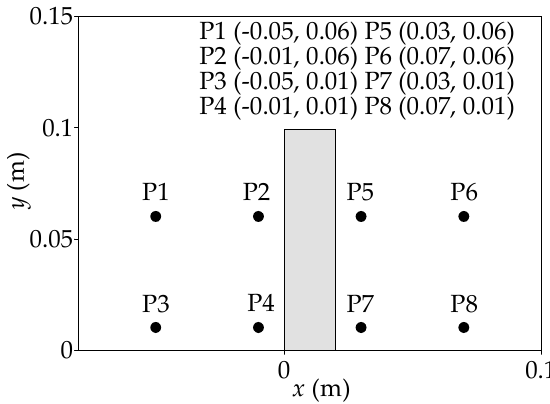
Figure 7. Initial positions of the traced particles.